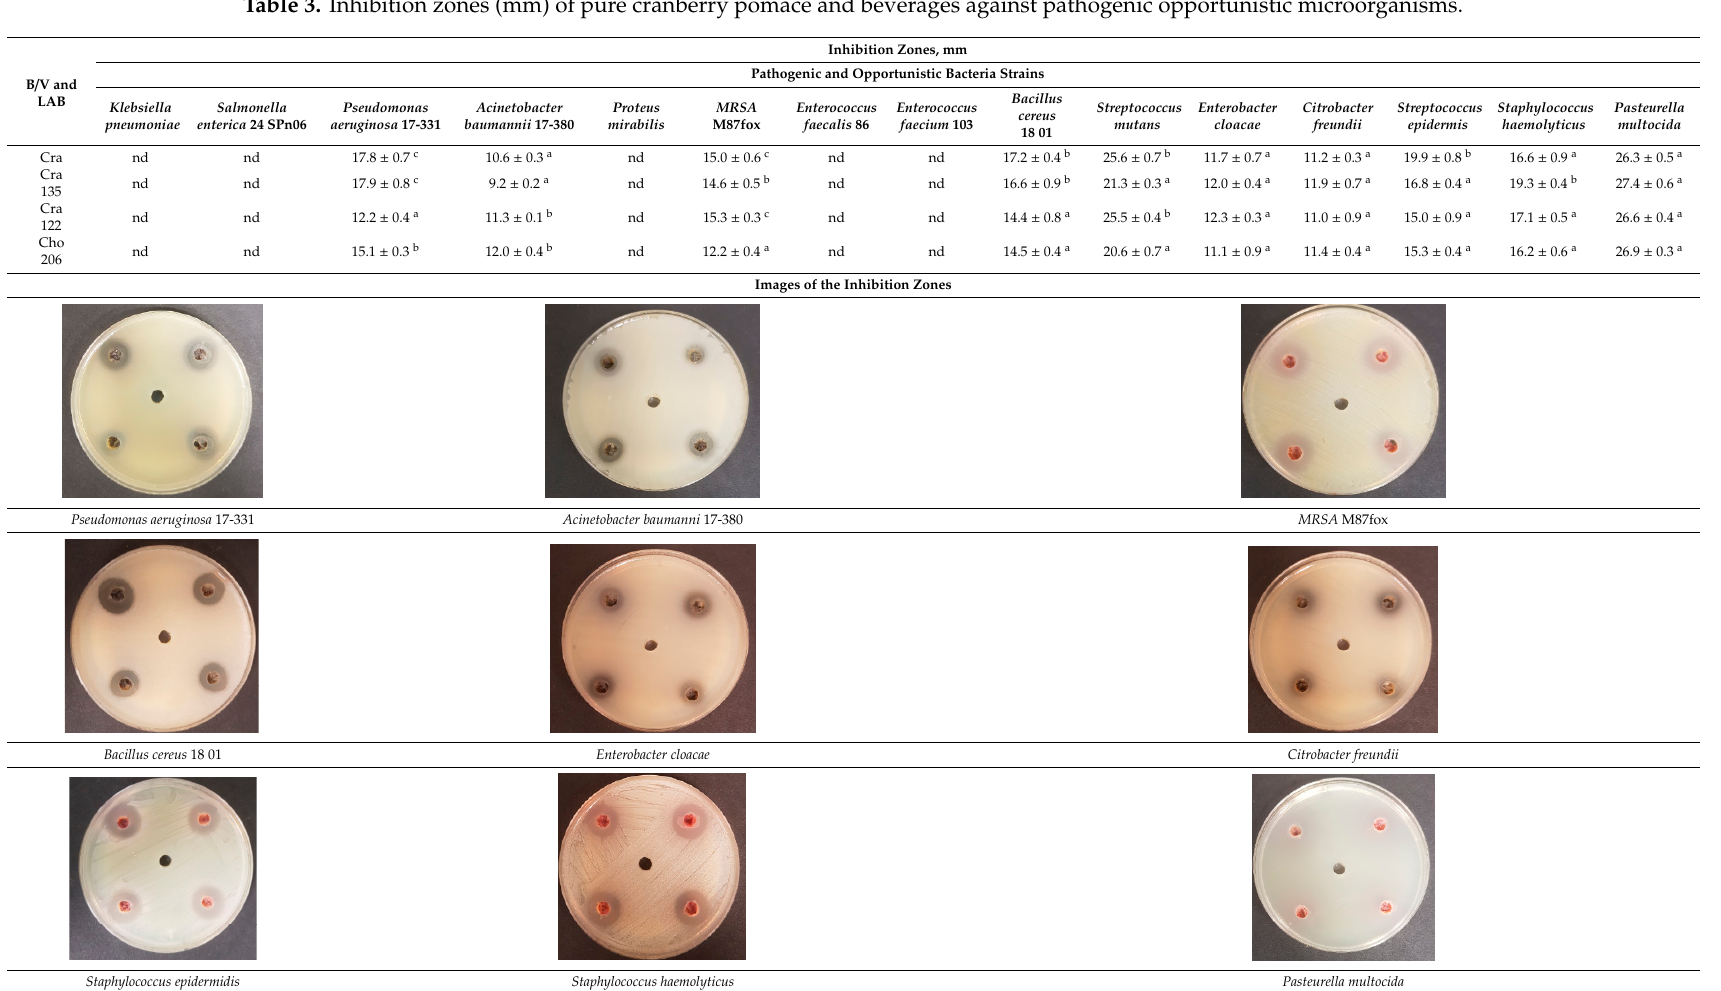
Table 3. Inhibition zones (mm) of pure cranberry pomace and beverages against pathogenic opportunistic microorganisms.